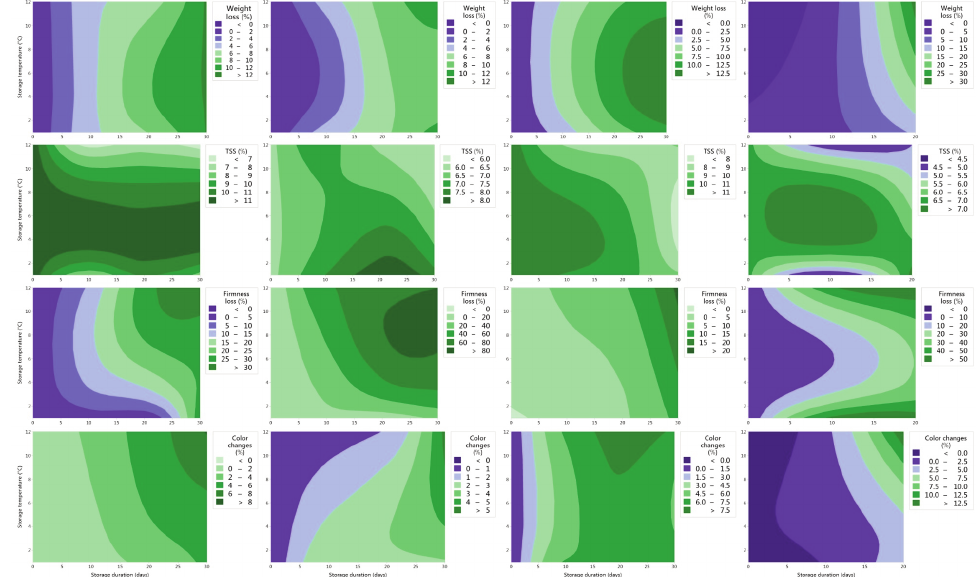
Fig. 4 ­ Contour plots of postharvest changes during cold storage period for the studied inbred lines. Each column of contour plots represents an inbred line (From left to right ‘Cm­UTKH’, ‘Cm­UTA’, ‘Cm­UTJ’, and ‘Cm­UTZ’, respectively). Each row of contour plots represents a postharvest attribute (From top to bottom Weight loss, TSS, Firmness loss, and Color changes, respectively). A significant difference between contour levels is present when the difference between contour levels are larger than 1.32, 1.67, 5.97, and 1.02 for Weight loss, TSS, Firmness loss, and Color changes, contours respectively